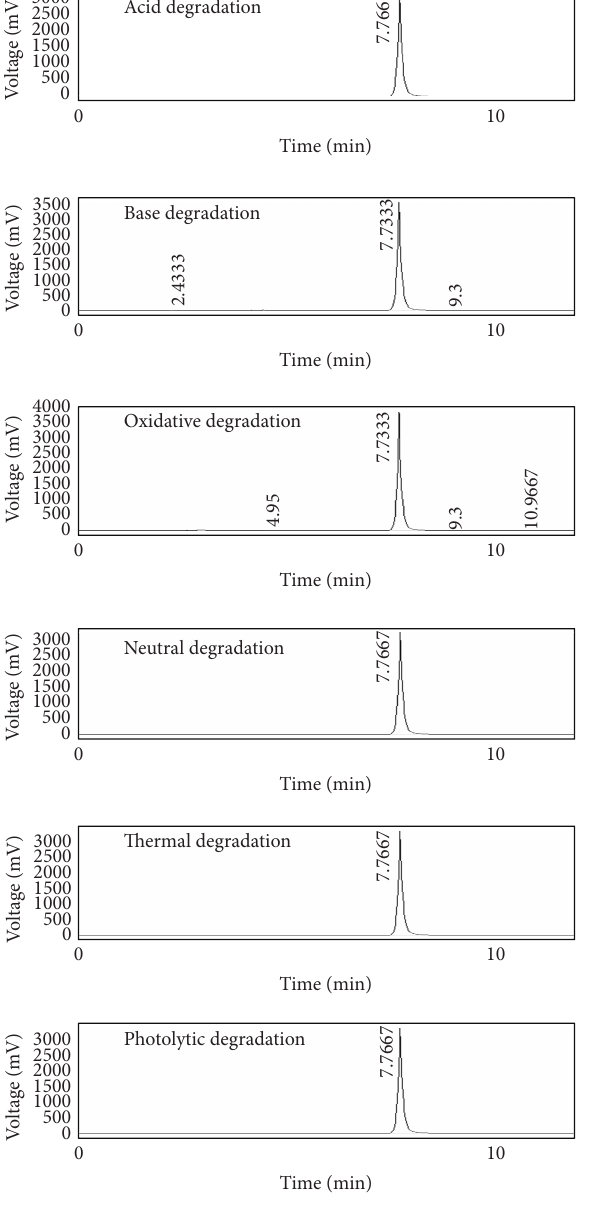
F 3: HPLC chromatograms of stressed test samples of tapentadol.